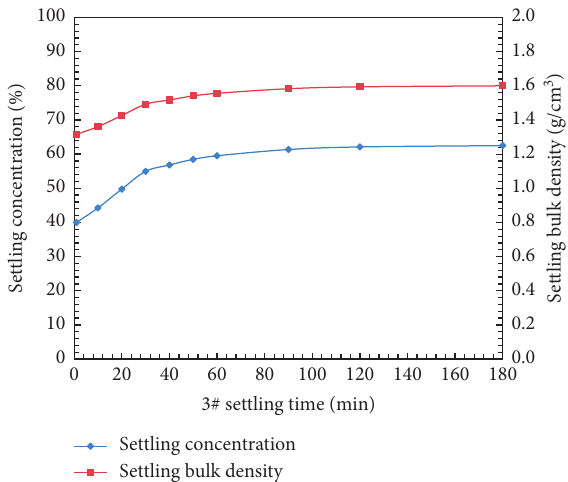
Figure 6: Variation curves of flocculation settling concentration and bulk density (#2).